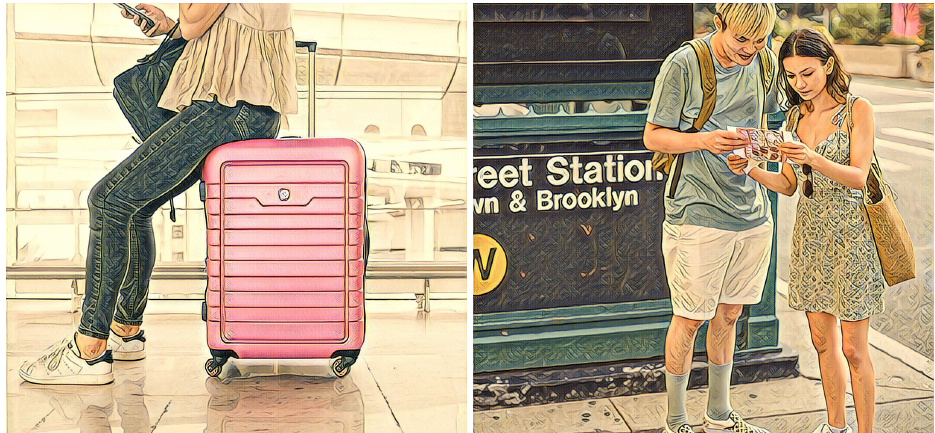
Figure 10. An illustration of SAIT for foreigner navigation